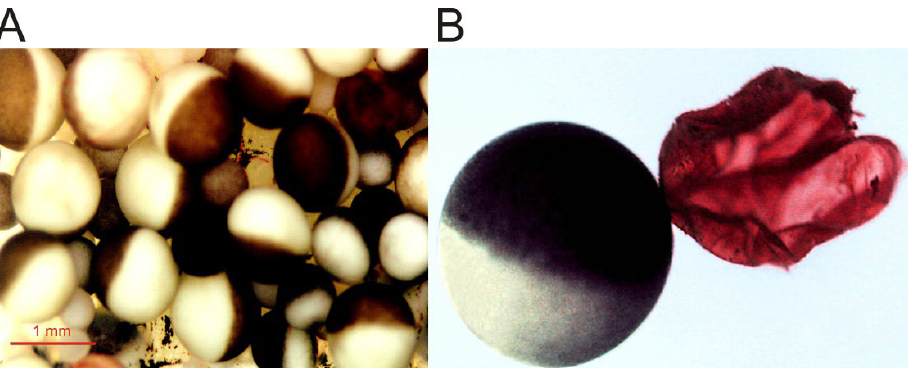
Figure 1. Micrographs of Xenopus oocytes . ( A ) Image of an opened and extended fragment of the Xenopus ovary lobule, showing oocytes at different stages of development. ( B ) Full-grown, immature oocyte, and the plasma membrane (together with its vitelline envelope) from another oocyte, manually isolated and stained with ink for better observation.